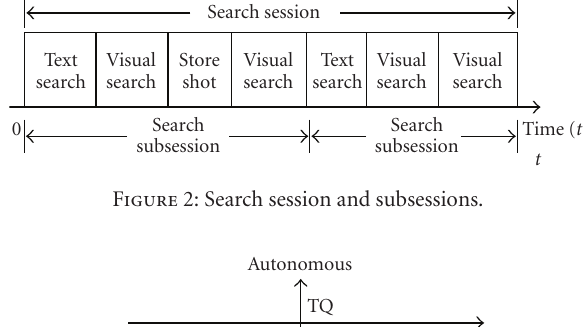
Figure 3: Classification of user